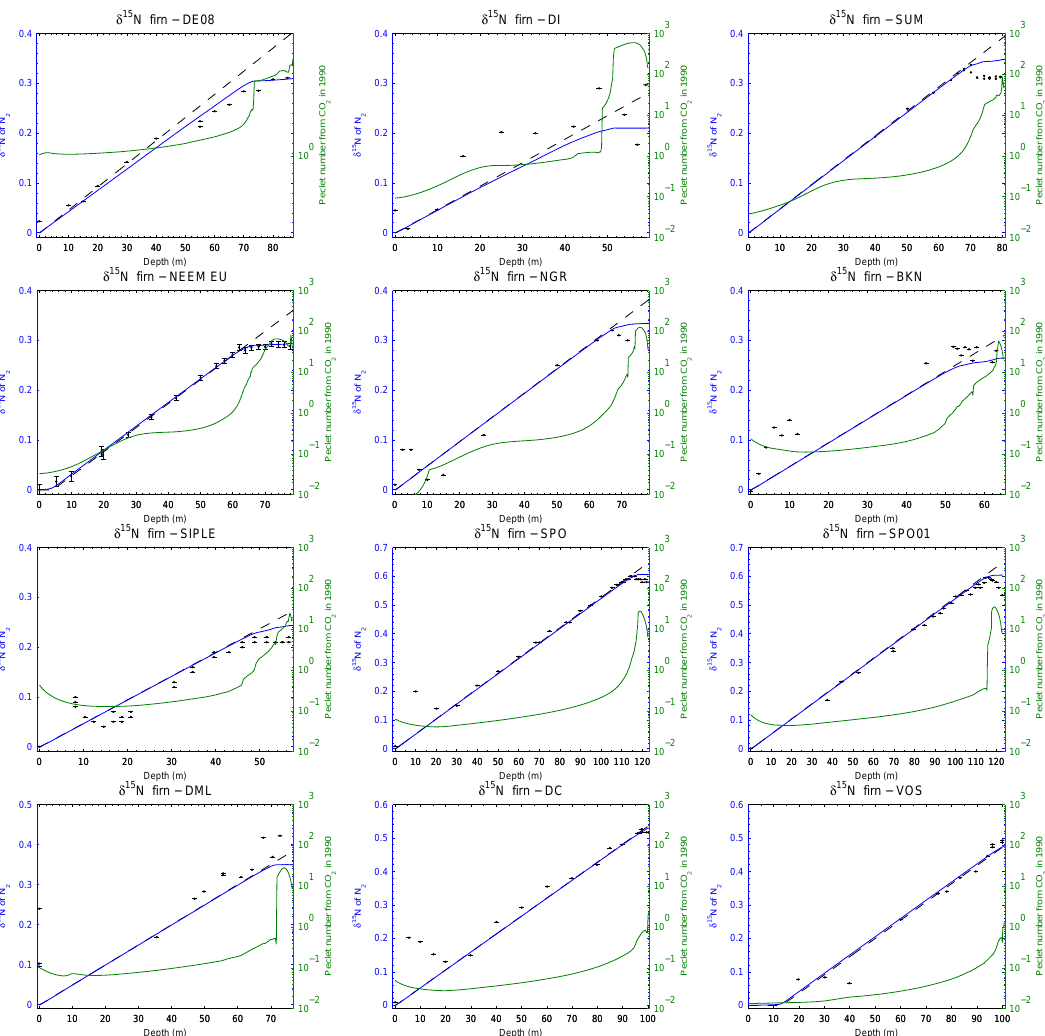
Fig. 8. Nitrogen ( δ 15 N of N 2 , left scale) as a function of depth at different sites: measured (“*”) versus modelled (blue “–”) isotopic composition and comparison with the gravity slope (“- - -”), along with the P´eclet number calculated from the concentration profile of CO 2 (green, right scale). δ 15 N stands for δ 15 N of N 2 (in ‰). The firn air sampling sites are shown by order of decreasing snow accumulation rate (see Table 2). Experimental data for NEEM are corrected for the effect of thermal diffusion and are average results for the NEEM EU and NEEM US drill holes (Buizert et al., 2012). At other sites, deviations of δ 15 N from the gravity slope in the upper firn are primarily explained by seasonal scale thermal diffusion. δ 15 N data at Summit are from Severinghaus, private communication. Other datasets are from Bender et al. (1994), Battle et al. (1996), Trudinger et al. (1997), Landais et al. (2006), Severinghaus and Battle (2006), Buizert et al. (2012), FIRETRACC (2007) and CRYOSTAT